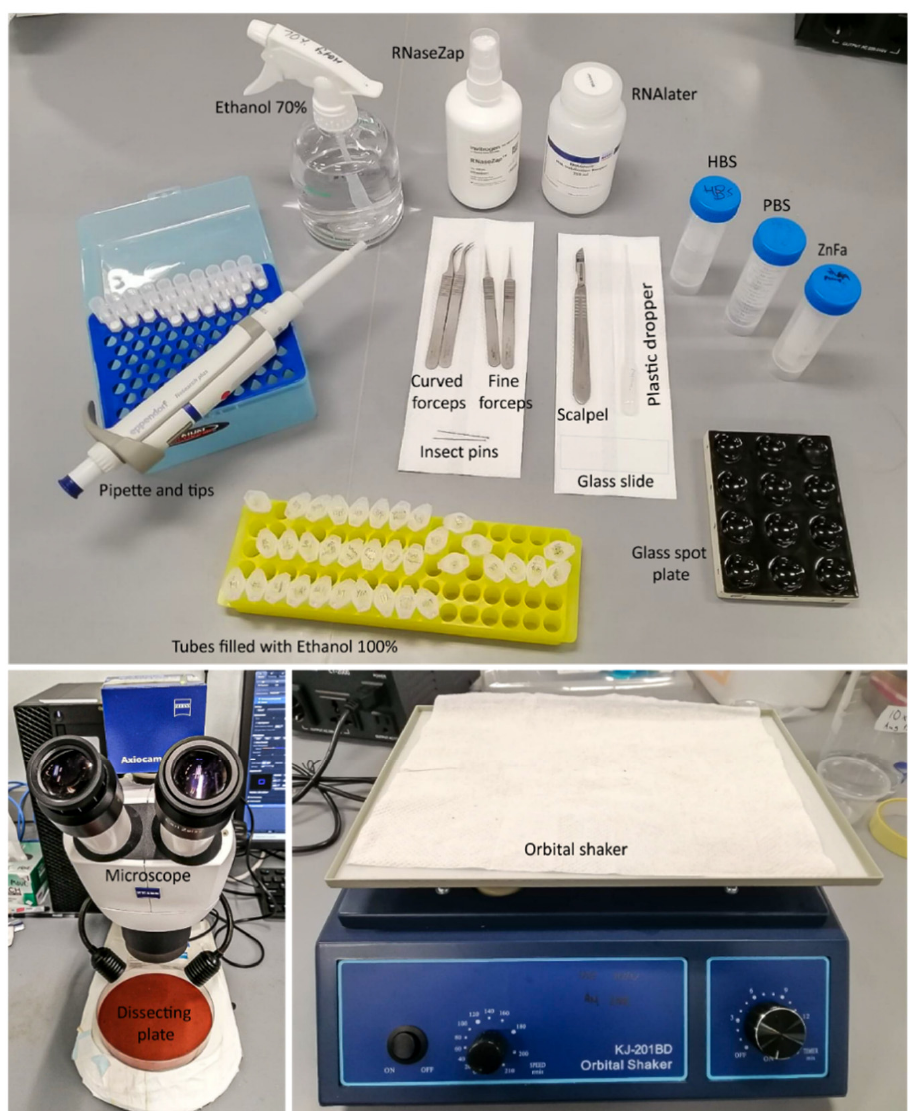
Figure 1. Equipment and materials needed for the dissection of adult, pupal, and larval brains.